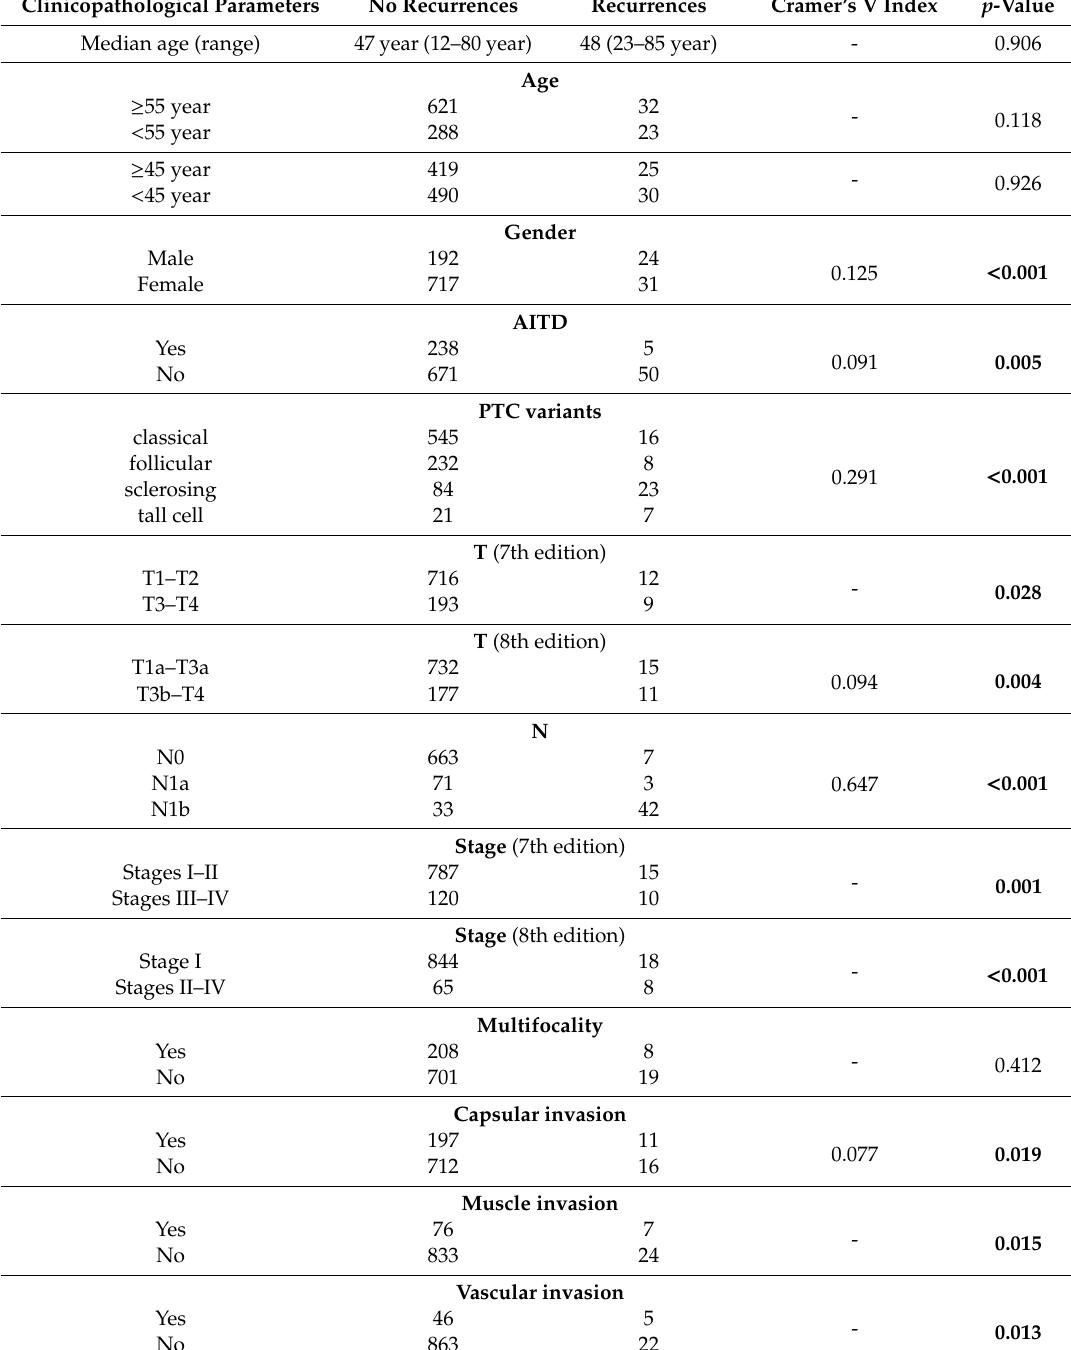
Table 1. Univariate analysis of the association between clinicopathological parameters and PTC recurrences. AITD, Autoimmune Thyroid Disease. p -values < 0.05 are evidenced in